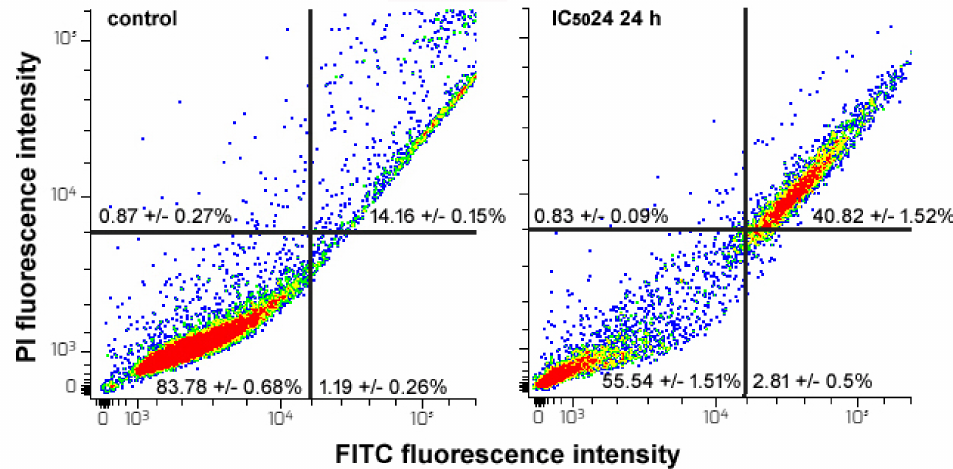
Figure 4. Flow cytometric assays for apoptosis in HepG2 cells cultured under control conditions or exposed to CFE IC 50 24 for 24 h. The plots show the results of representative experiments, and the percentages indicated as the mean ± s.e.m. of three independent experiments refer to viable annexin-V − /PI − cells (bottom left quadrant), early apoptotic annexin-V + /PI − cells (bottom right quadrant), late apoptotic annexin-V + /PI + cells (top right quadrant) and necrotic annexin-V − /PI + cells (top left